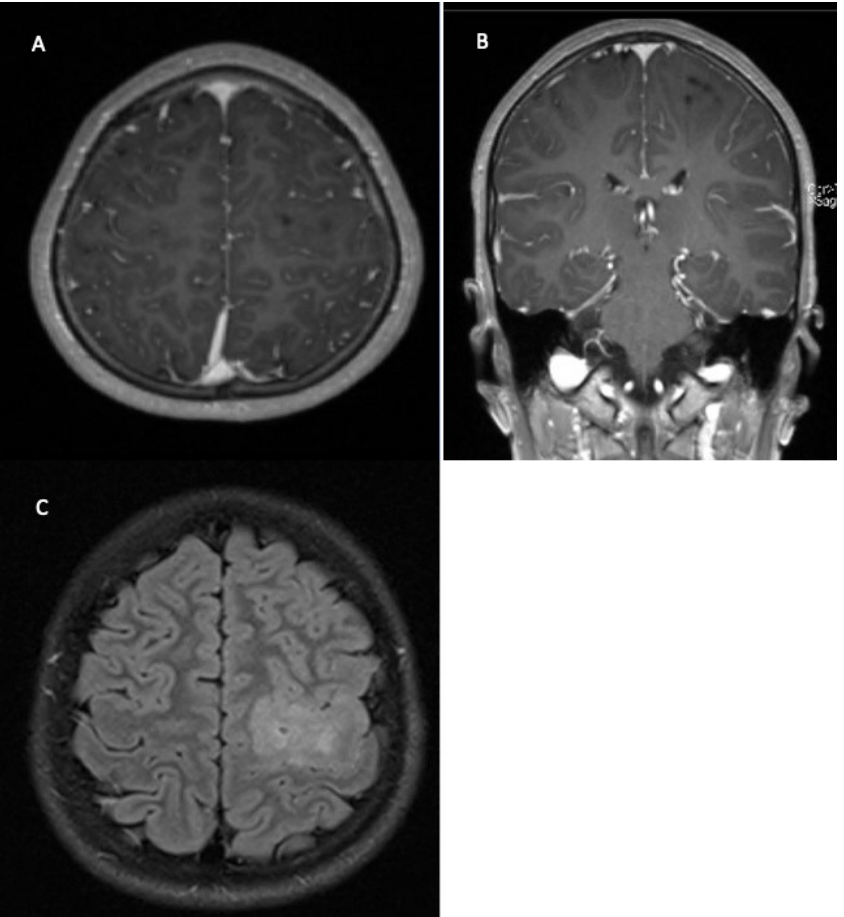
Figure 4. 13 year old boy with right hand paresis and initial focal seizure. Contrasted T1 MRI shows non-enhancing cortical tumor ( A , B ), FLAIR sequence with diffuse cortical lesion ( C ). Diagnosis: diffuse hemispheric glioma, H3 G34-mutant (WHO grade 4). Therapy: Near total resection, conformal radiation therapy, temozolomide, tumor treating fields (TTF).